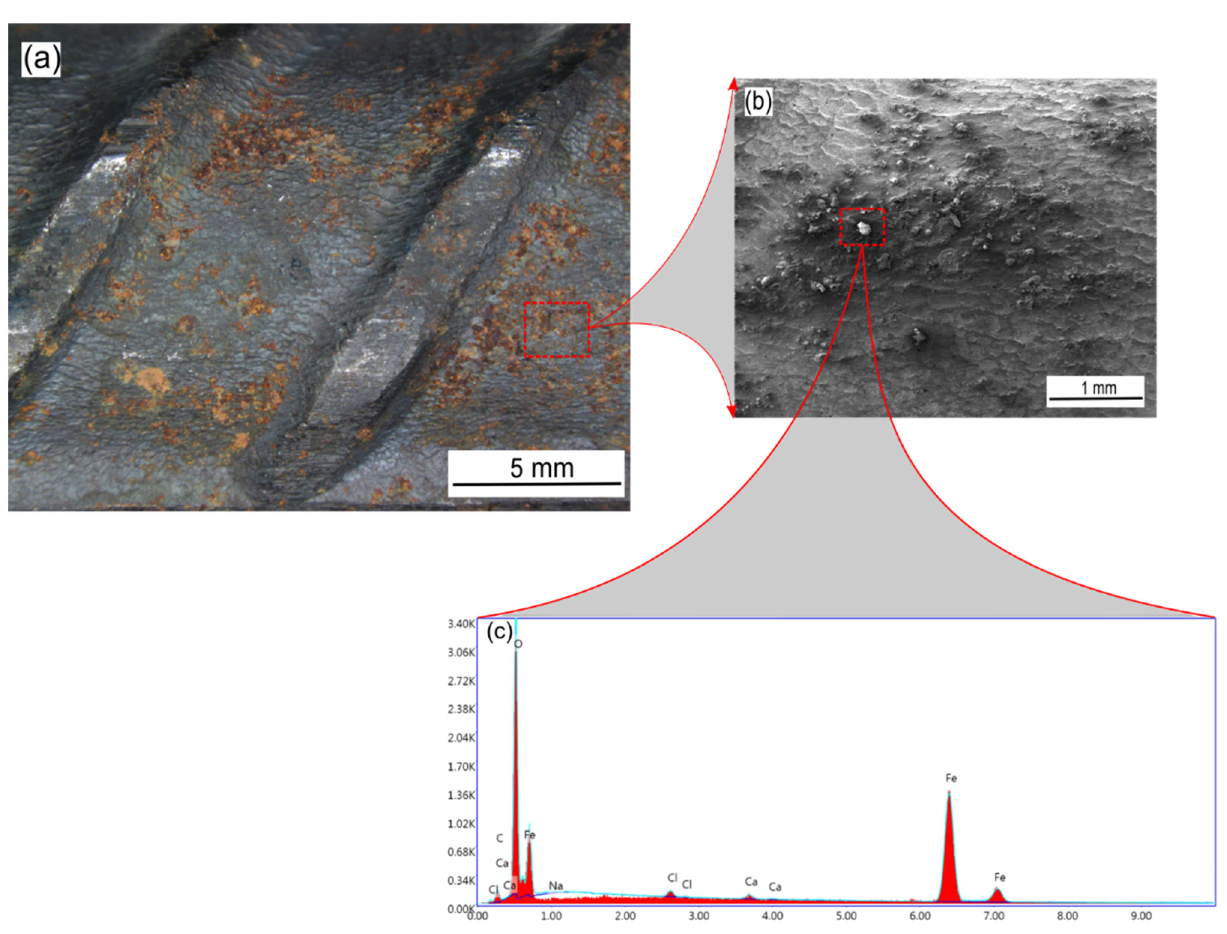
Figure 12. Optical and SEM micrograph of an uninhibited carbon steel rebar in 0.6 M Cl − SCPS at 25 °C. ( a ) Surface of the rebar at ×10, ( b ) surface of the rebar at ×40, and ( c ) EDX elemental spectrum of the surface of the rebar.